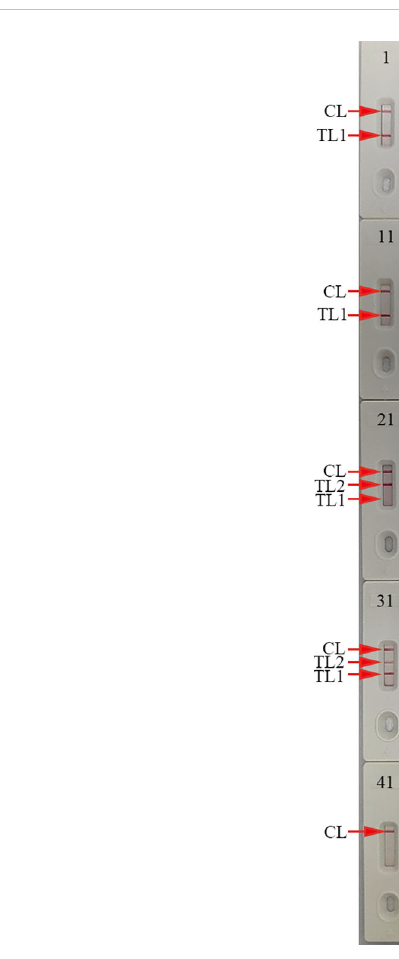
FIGURE 7 mLAMP-AuNPs-LFB assay speci fi city with different strains Assay speci fi city was evaluated using different nucleic acid templates. Ampli fi cation products were tested using AuNPs-LFBs: 1 – 14, C. trachomatis serovars A, B, C, D, E, F, G, H, I, J, K, L1, L2, and L3 ompA plasmids; 15 – 20, C. trachomatis clinical samples; 21, N. gonorrhoeae orf1 plasmids; 22, N. gonorrhoeae reference strain ATCC 49926; 23 – 28, N. gonorrhoeae clinical samples; 29 – 34, C. trachomatis and N. gonorrhoeae clinical samples; 35, Neisseria meningitides ; 36, Ureaplasma urealyticum ; 37, Escherichia coli ; 38, Staphylococcus aureus ; 39, human papillomavirus; 40, Mycoplasma pneumonia ; 41, Haemophilus in fl uenza ; 42, Streptococcus pyogenes ; 43, human enterovirus EV71; 44, Coxsackie virus CAV16; 45, Klebsiella pneumoniae ; 46, Pseudomonas aeruginosa ;47, Candida glabrata ; 48, Cryptococcus neoformans ; 49, Listeria monocytogenes ; 50, negative control (DW). Key: CL, control line; TL, test line.